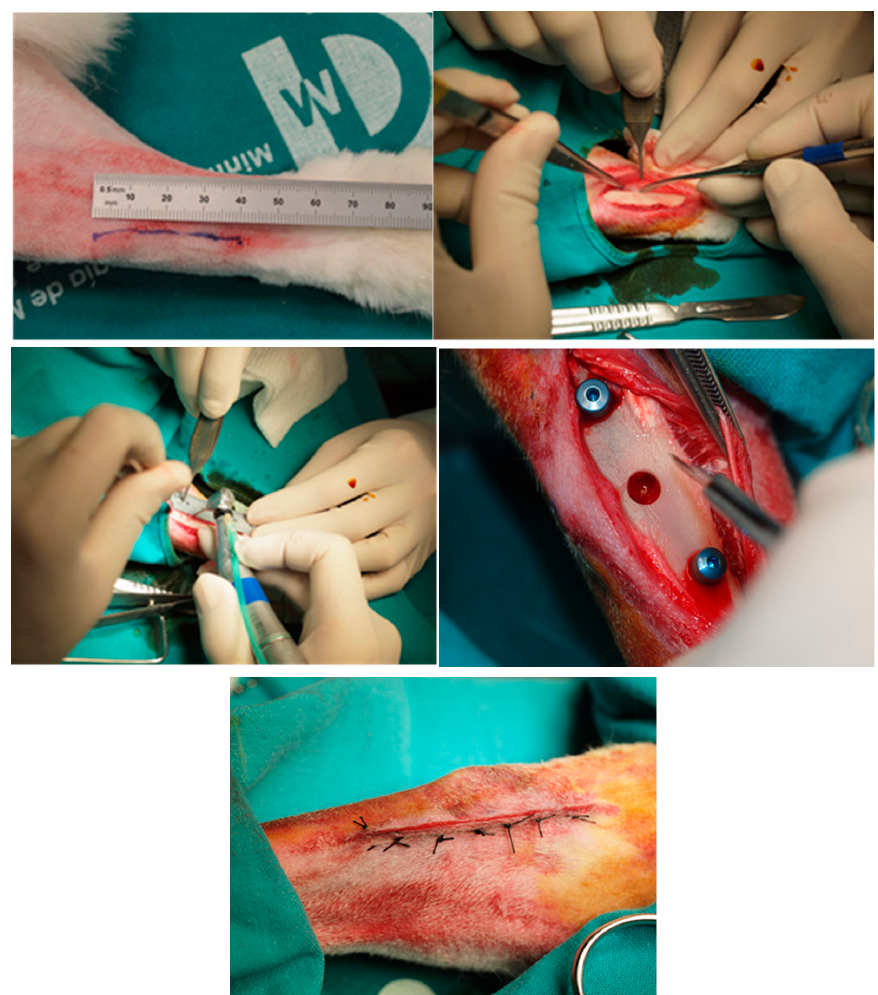
Figure 1. Surgical procedure. Above, left: Identification of the operating area. Above, right: Incision and separation of the periosteum. Middle, left: Reaming of the alveoli for implants. Middle, right: Insertion of the implants in the tibiae of rabbits. Bottom: Suture of the incision. The comparison between different implants is made in respect to different parameters: –Bone Surface Area (BS), which involves measuring the surface of a structure to characterize 3D objects such as trabecular bone and can be calculated by the construction of a triangular surface mesh using the marching cubes algorithm, thus computing the sum of the triangular areas making up the mesh to obtain the total bone surface area [29,30]. –Trabecular Thickness (TBTH) and Max. Trabecular thickness. Trabecular bone microarchitecture is calculated by a plugin based on Bob Dougherty’s Local Thickness Plugin, which assesses the mean and the standard deviation directly from the pixel values in the resulting thickness map. These parameters are used as predictors for the resistance to fracture and the healing process [31,32]. –Bone Volume, Total Volume, and the Bone Volume Fraction (BV/TV). These parameters are